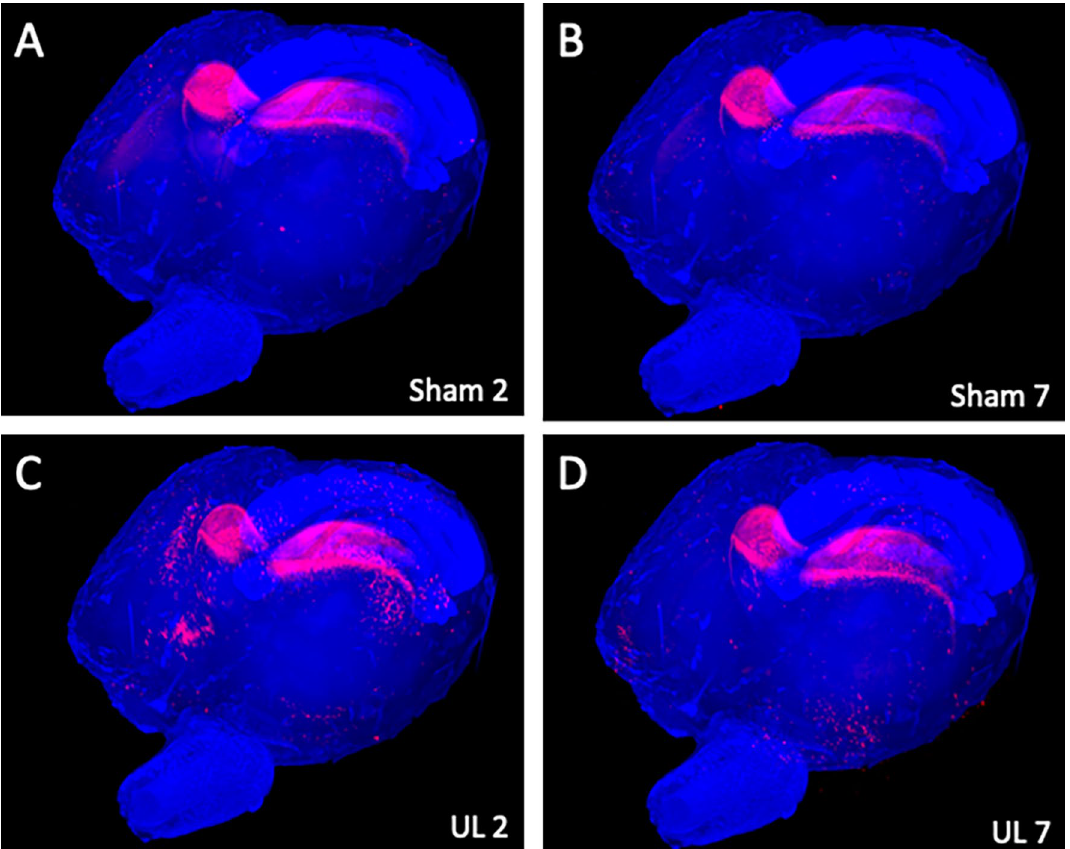
Figure 2. Representative whole-brain images of each group. Panoramic view of whole-brain imaging using CUBIC analysis. Red fluorescence indicates activated neurons. There were many non-specific activated neurons in the hippocampus in all images. ( A ) Images obtained 2 days after sham surgery. ( B ) Images obtained 7 days after sham surgery. ( C ) Image obtained 2 days after unilateral (left) labyrinthectomy (UL). ( D ) Image obtained 7 days after